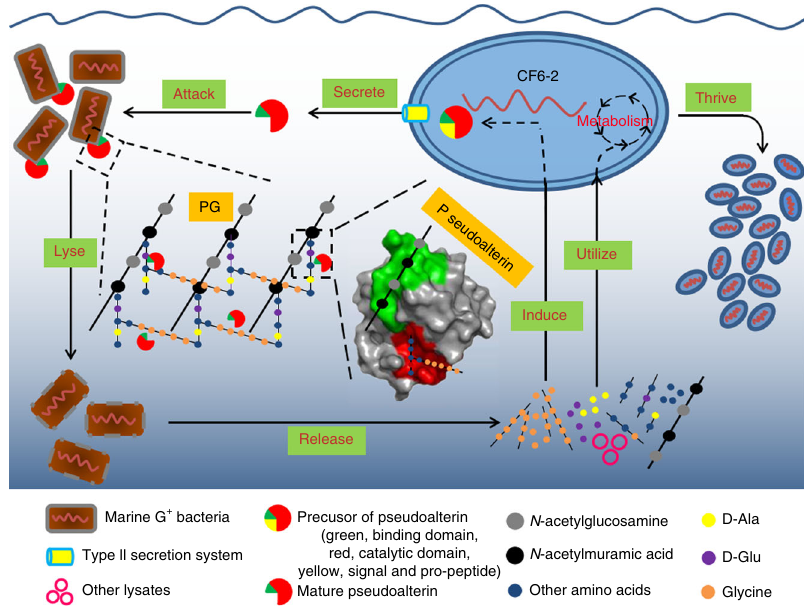
Fig. 8 A model for Gram-negative strain CF6-2 preying on Gram-positive marine bacteria for nutrients with the secreted protease pseudoalterin as a weapon. Strain CF6-2 lyses Gram-positive bacterial cells by secreting the metalloprotease pseudoalterin to degrade the PG in Gram-positive bacterial cell wall, which leads to the collapse of the cell wall and subsequent lysis of the cell. Then, strain CF6-2 utilizes the D / L -amino acids and the oligopeptides released from PG degradation and the substances from the inside cell to thrive. In the meantime, the released glycine and glycine-enriching oligopeptides from the degradation of Gram-positive bacterial PG induce the synthesis of pseudoalterin in strain CF6-2, and then the synthesized pseudoalterin is secreted through the T2SS of strain